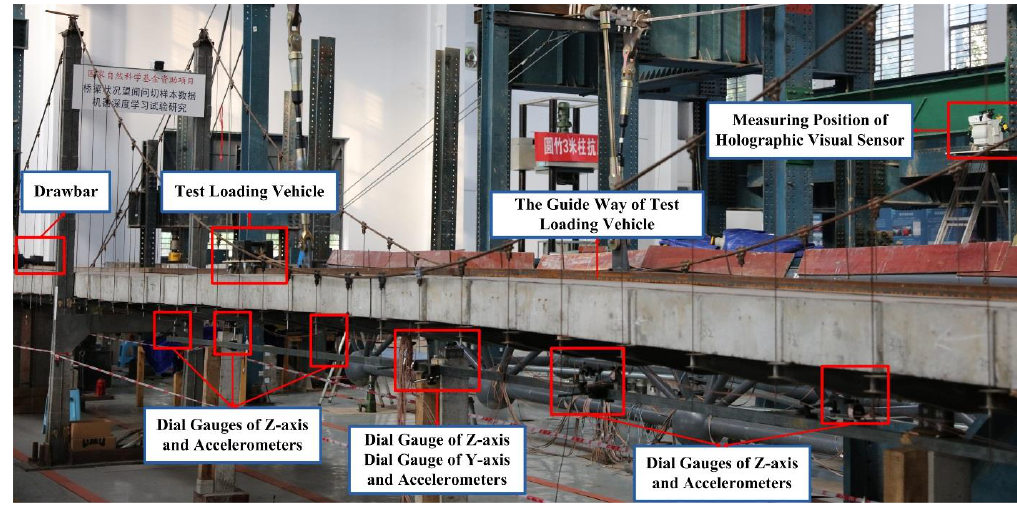
Figure 8. Experiment site layout .